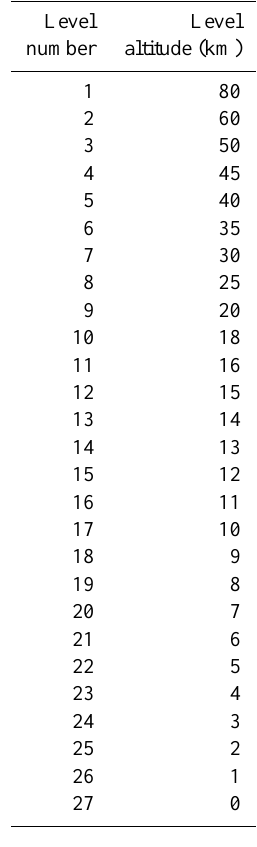
Table 2. MODIS channels used in simulations. Table 3. Vertical levels used in simulation